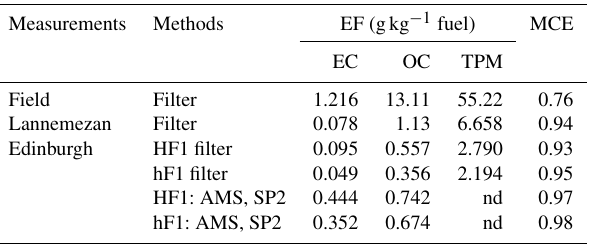
Table 6. EF for fuelwood burning of this study for field and com- bustion chamber